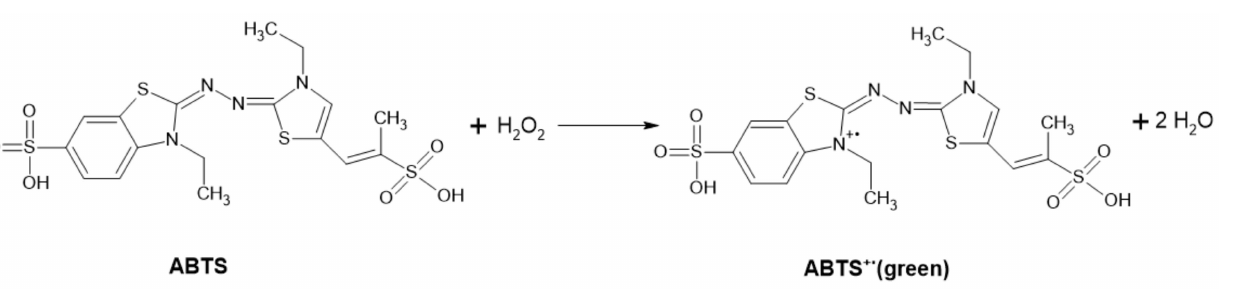
Figure 16. Scheme of the ABTS peroxidase coupled